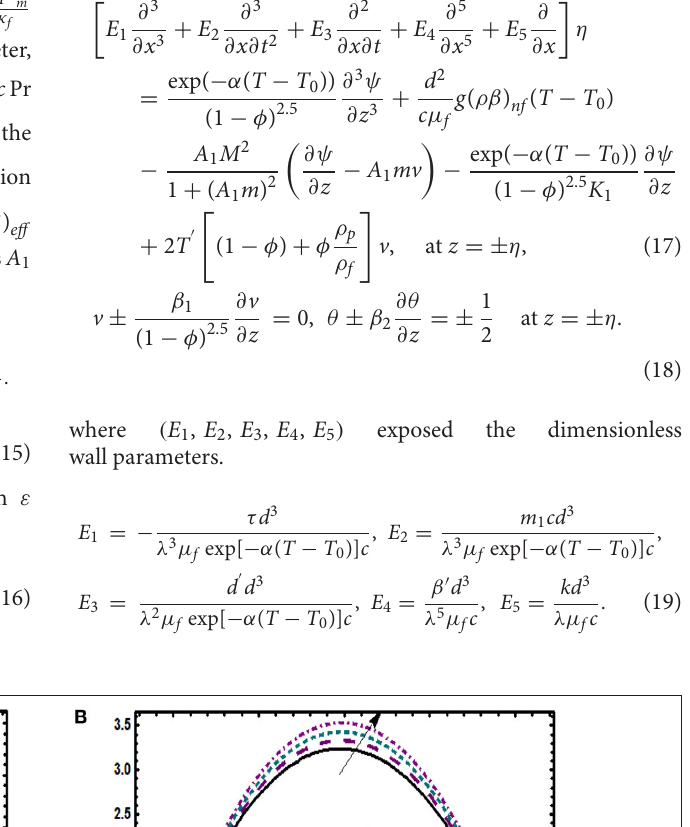
Frontiers in Physics |